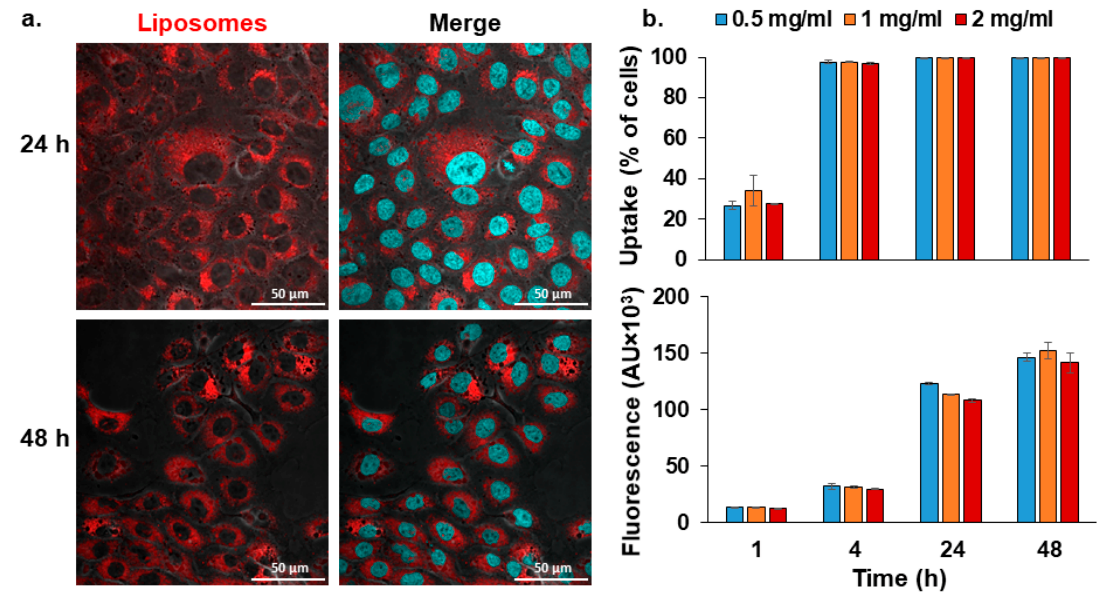
Figure 5. The internalization of Lip DOPE by keratinocytes (HaCaT) cell culture. Qualitative (confocal microscopy; ( a ) quantitative (flow cytometry analysis; and ( b ) assessment of cellular uptake of Lip DOPE (fluorescently labeled with Rhodamine-PE; 2 mg/mL lipids concentration). The liposomal membrane is depicted in red, and cell’s nuclei in cyan (scale bar = 50 µm). The fluorescence intensities were normalized to untreated cells (mean ± SD).